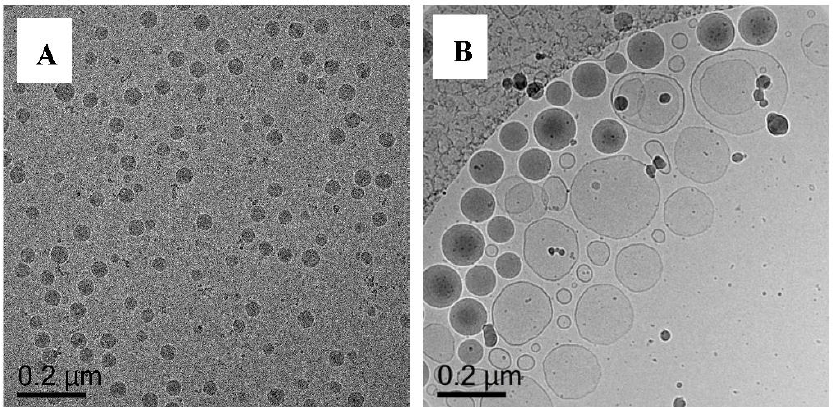
Figure 10. Cryo-TEM micrographs of Exp 4 ( A ), polymerization of Oligo 3 without DODAB vesicle and Exp 5 ( B ), polymerization of Oligo 3 with DODAB vesicle. Both polymerized with MA/EGDA as the monomer. Additional images in Figure S3 (Exp 4) and Figure S4 (Exp 5).